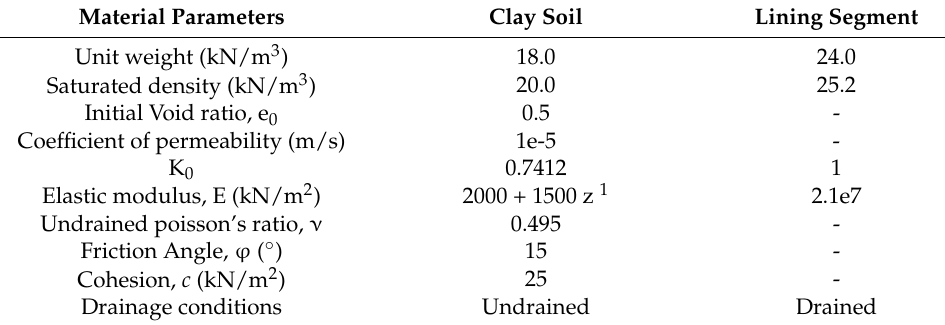
Table 2. Material parameters adopted in the finite element analyses.